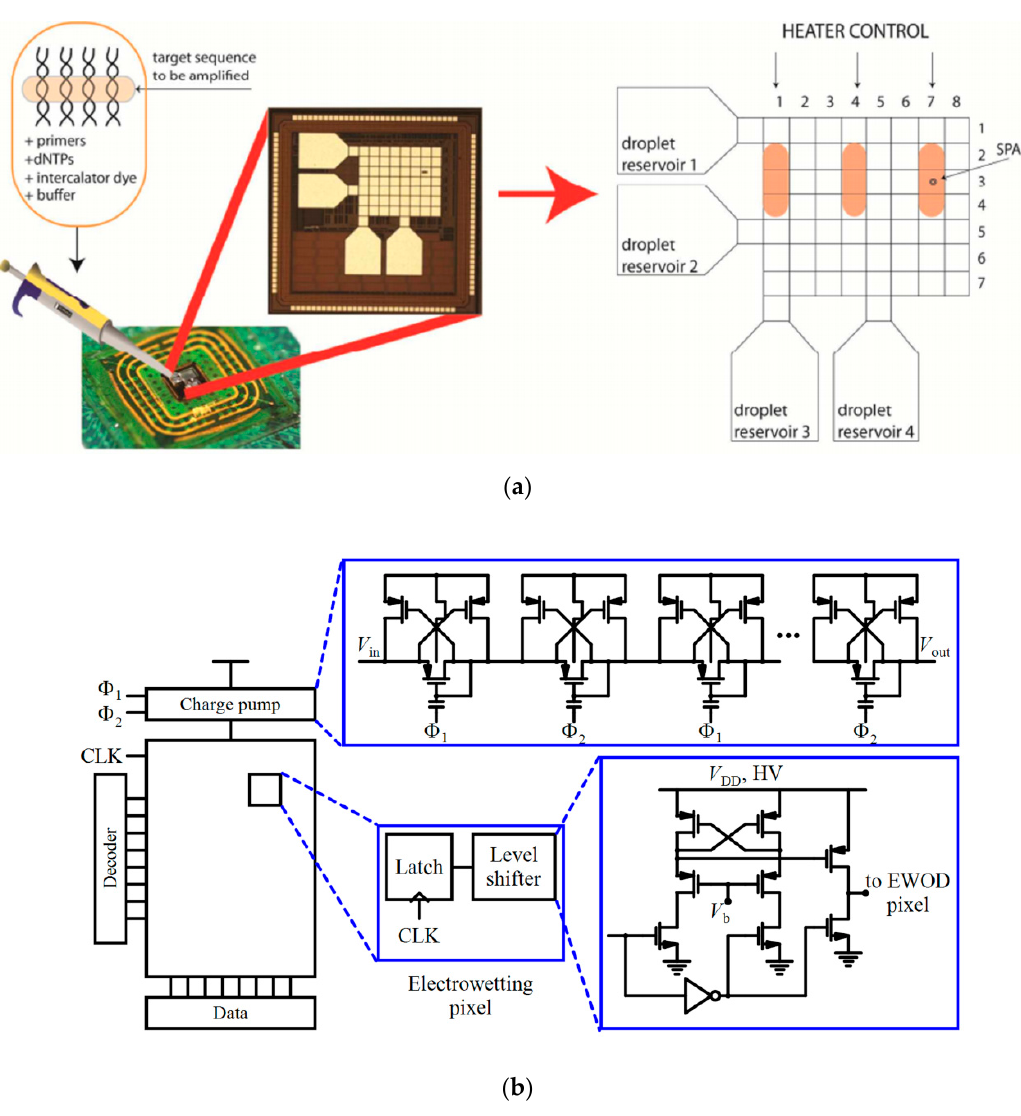
Figure 4. ( a ) The CMOS qPCR LoC containing a 7 × 8 array of electrodes for EWoD droplet transport [28], ( b ) The electrowetting control circuitry and the custom level shifter interfaces used in the system shown in ( a ).